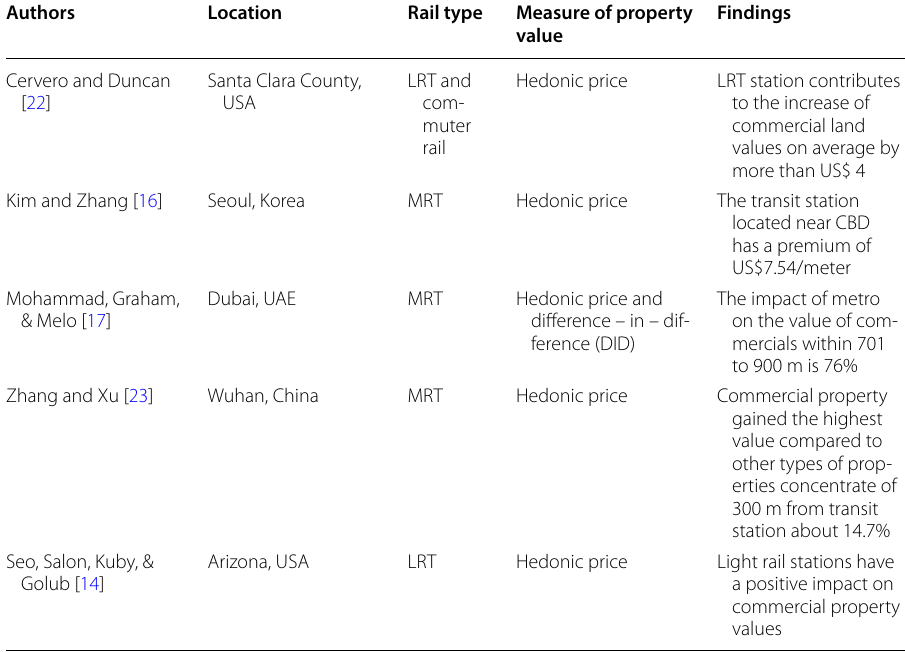
Table 1 Selected studies on the impact of rail transit on commercial properties